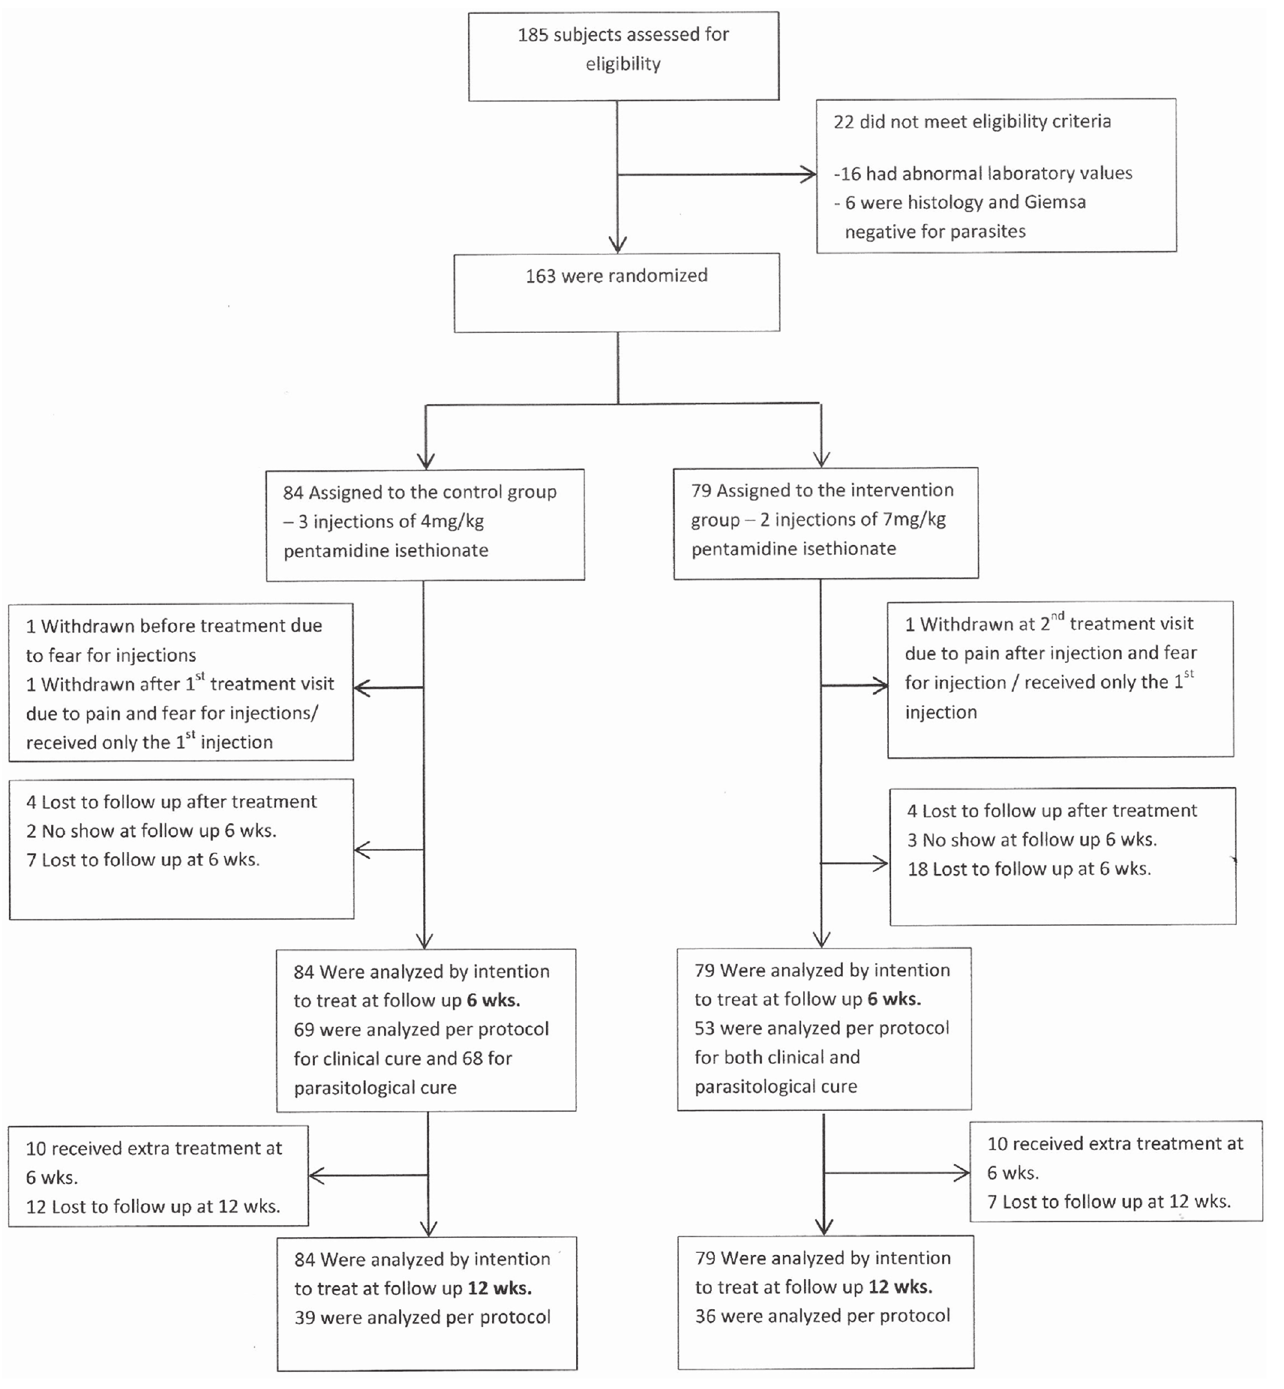
Fig 1. PELESU study in patients with cutaneous leishmaniasis in Suriname from 2010 – 2013: study enrollment, randomization and follow-up.